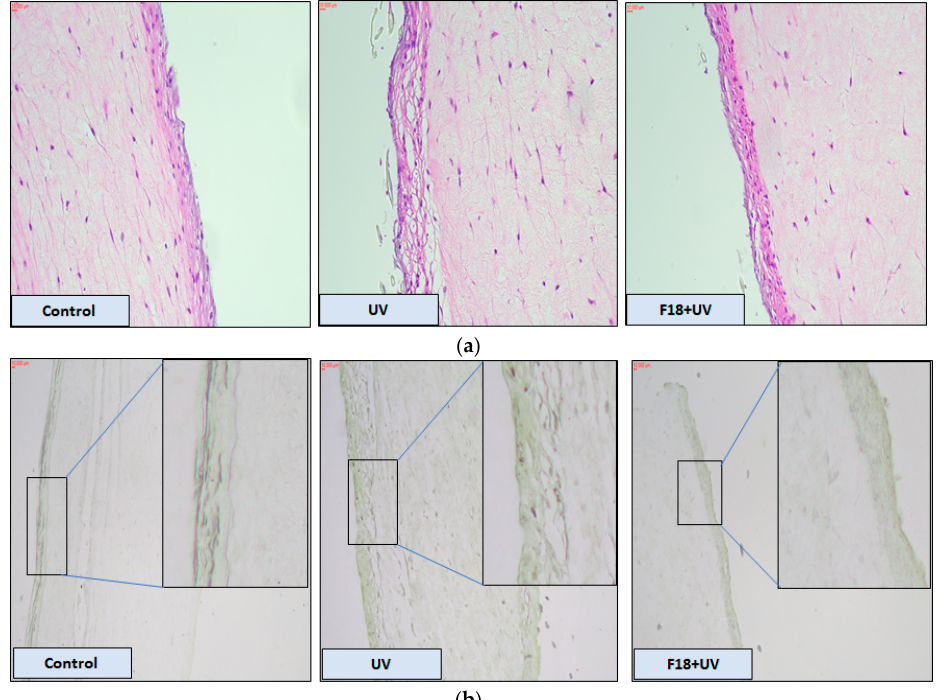
Figure 9. H&E staining and TUNEL assay in reconstituted human 3D skin model. ( a ) H&E staining showing morphological changes after the skin culture was treated with control, UV alone or F18 combined with UV. Magnification: 20×. ( b ) TUNEL assay demonstrated UV induced apoptosis can be attenuated by F18 treatment. Enlarged images emphasize apoptotic positive cells (magnification 10×). Scale bars, 10 μ m.